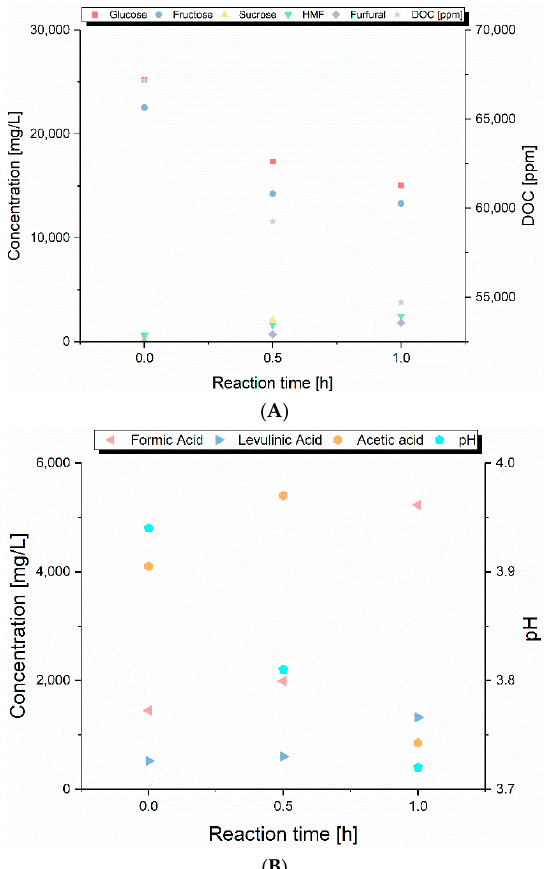
Figure 4. ( A ) Concentration of the sugars, 5-hydroxymethylfurfural (HMF) and furfural as well as dissolved organic carbon (DOC); ( B ) concentration of the acids in the process liquid and their pH after hydrothermal treatment (HT) at 160 °C for different reaction times.